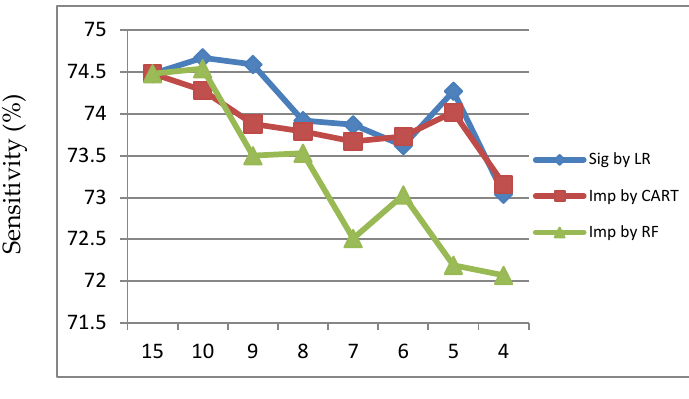
Figure 13. Sensitivity of LR with input of significant or important variables.